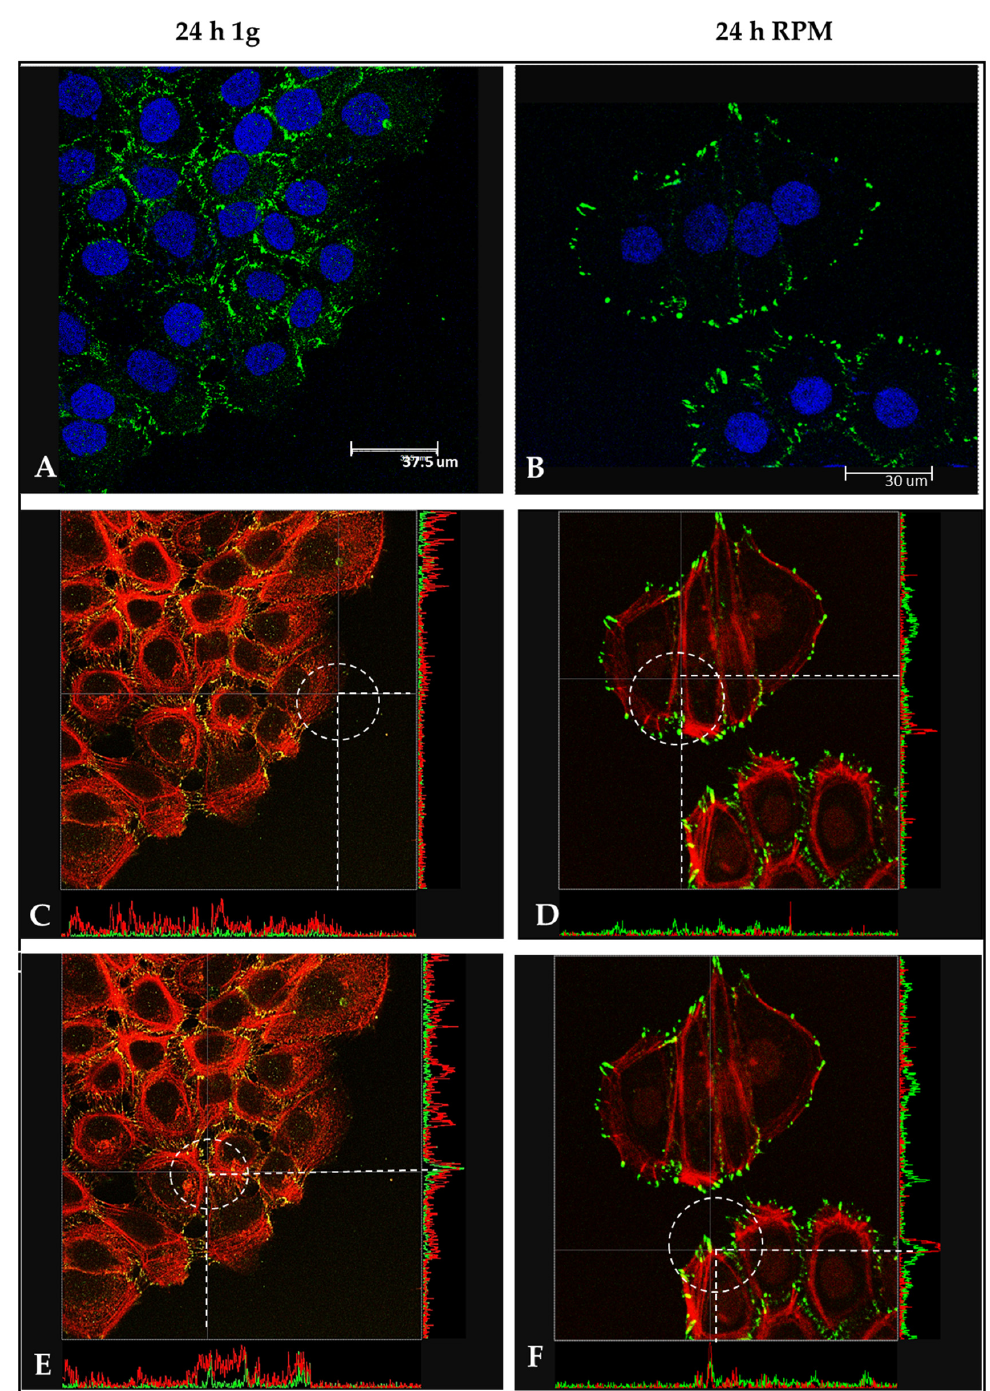
Figure 4. Representative images of colocalization analysis of vinculin (green) and F-actin (red) in HaCaT cells cultured in normal gravitational condition (1g) and microgravity conditions (RPM) for 24 h. In A, vinculin distribution is shown. Vinculin is distributed in cell–cell contact in control condition ( A ), (Scale bars 37.5 µm), while it is mostly displaced at the free front of cell membrane in RPM-treated cells ( B ) Scale bars 30 µm). ( C – F ) show the colocalization analysis of vinculin and F-actin. In the X/Y axes, at the level of the dotted lines, the colocalization (green and red picks) is shown. Colocalization is evident at the level of membrane protrusion in RPM cultured cells (( D ), dotted circle) and in cell–cell contact in 1g cultured cells (( E ) dotted circle). Contrarily, no colocalization is observed at the level of membrane protrusion in on 1g cultured cells (( C ), dotted circle) and in cell–cell contact in RPM cultured cells (( F ), dotted circles).